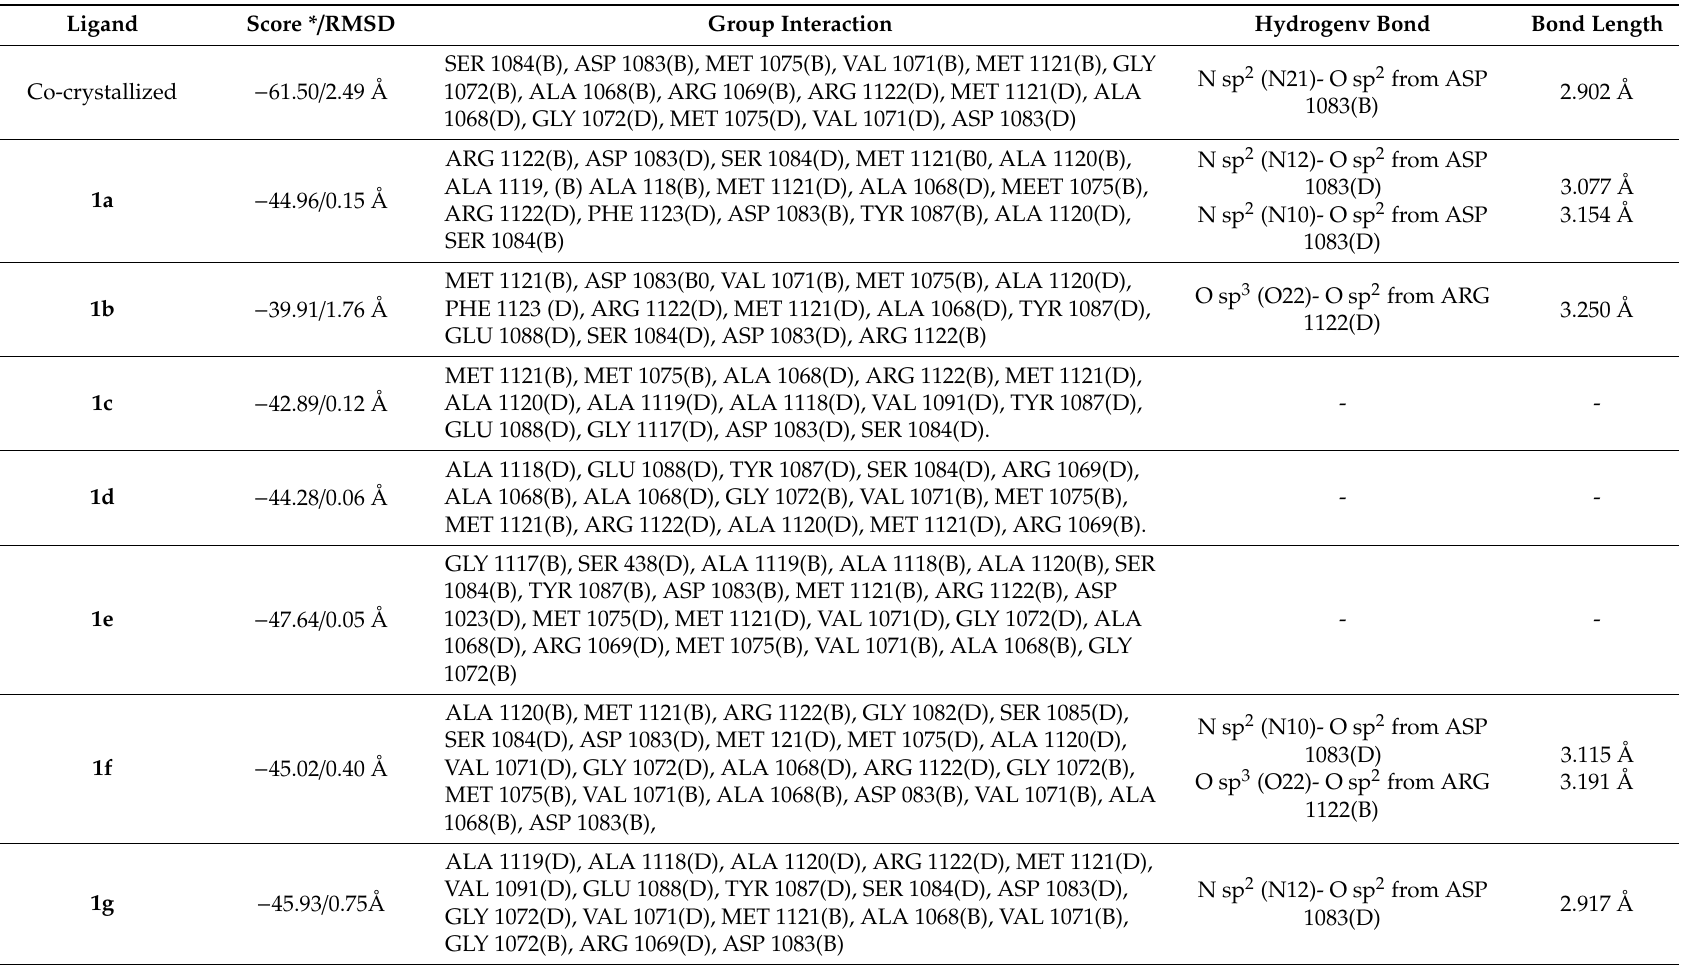
Table 2. The list of intermolecular interactions between the ligand molecules docked with 2XCS using CLC Drug Discovery Workbench